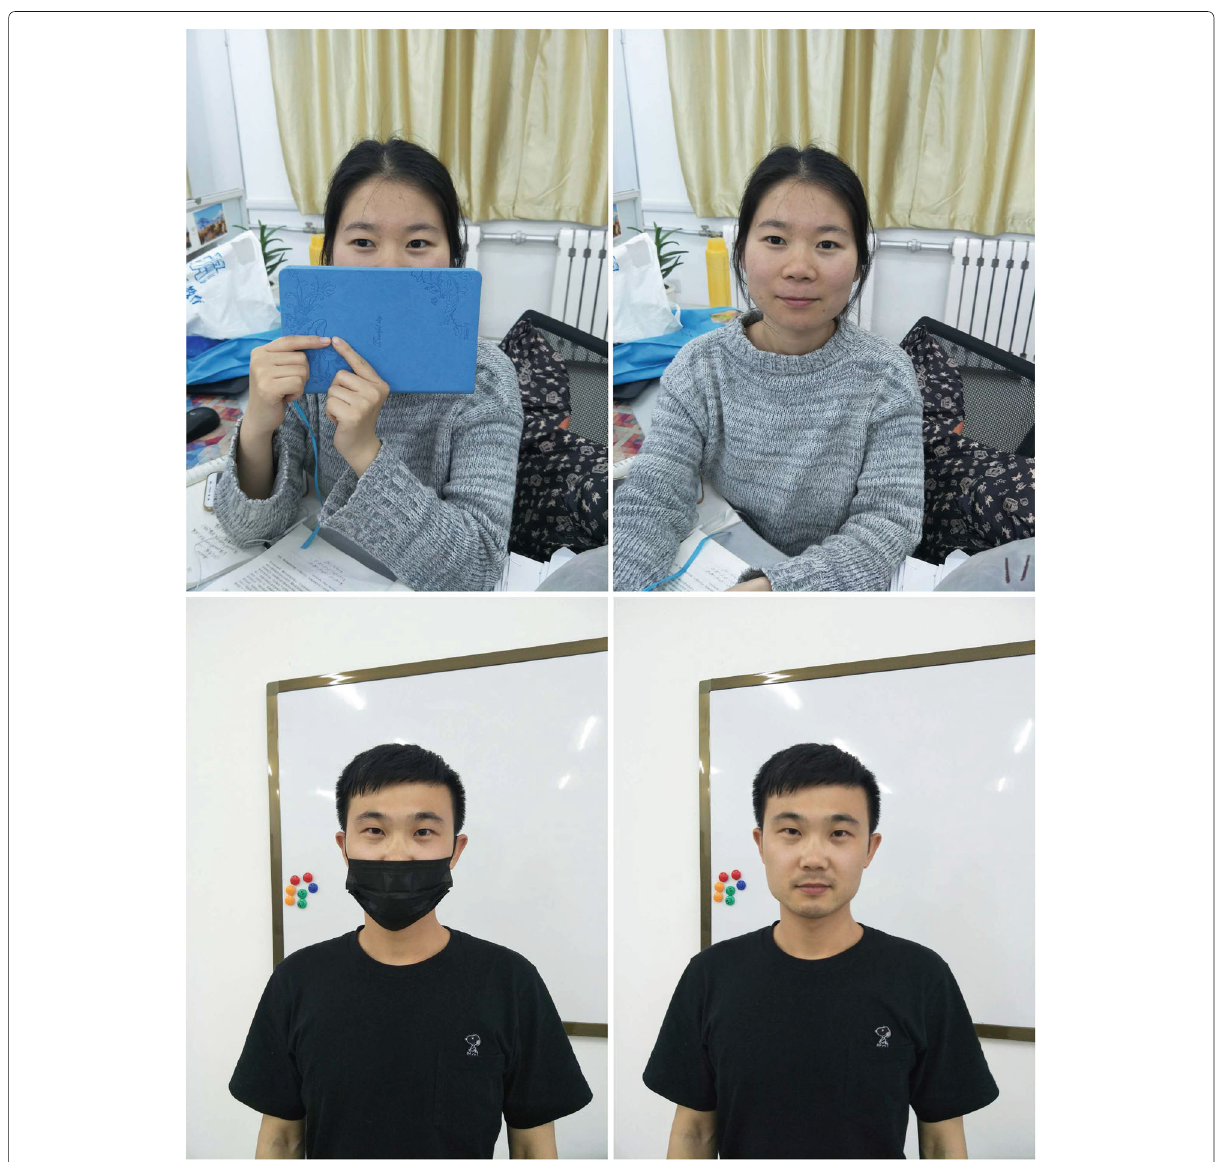
Fig. 2 Image samples in the manually collected database